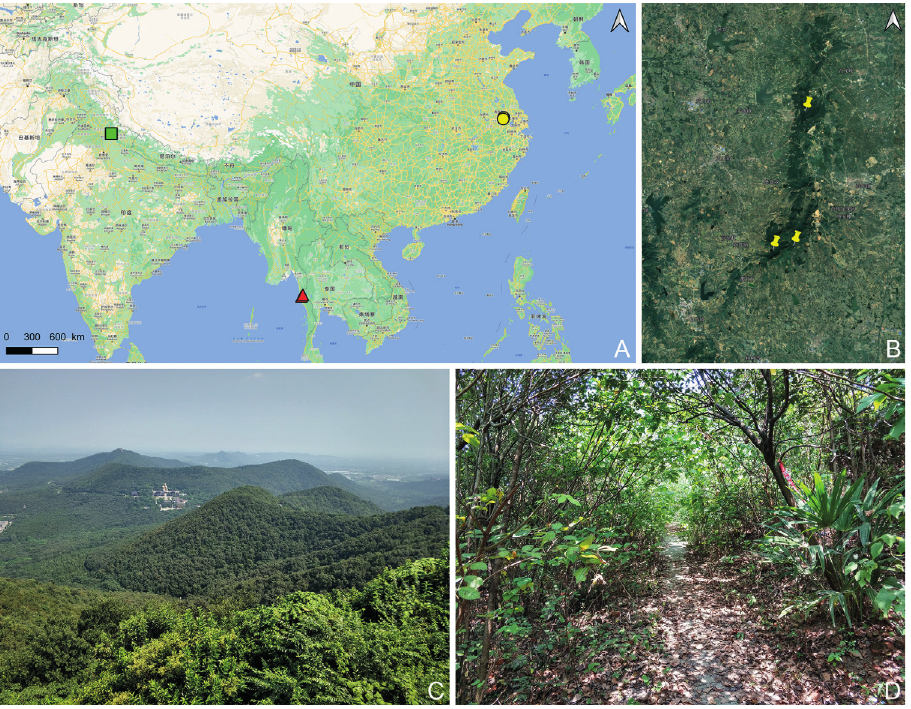
Figure 2. Distribution ( A, B ) and habitat ( C, D ) of Trisiniotus . A distribution of T. taoismus sp. nov. (circle), T. nitidulus (triangle), and T. nodicornis (square) B distribution of T. taoismus sp. nov. in the Mao- shan mountains C environment of Mao-shan D habitat of T. taoismus sp.